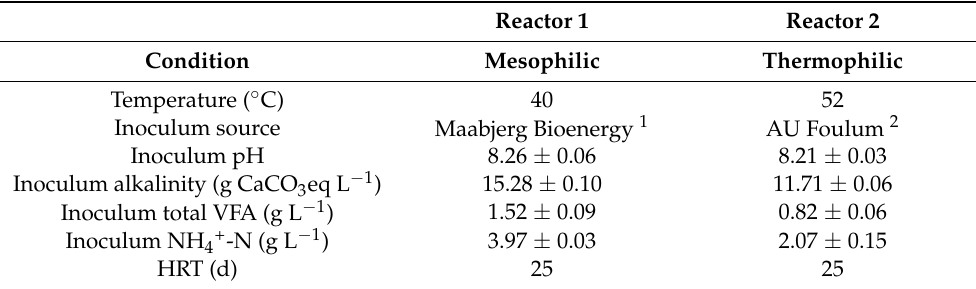
Table 2. Continuous reactor